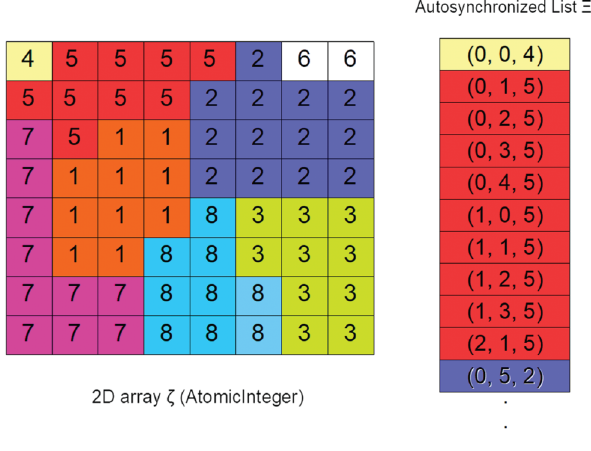
Figure 4: Data structures needed for parallel implementation of the Potts cell model. Several cells are illustrated (with different colors) in the grid ζ , and its representation in the list Ξ